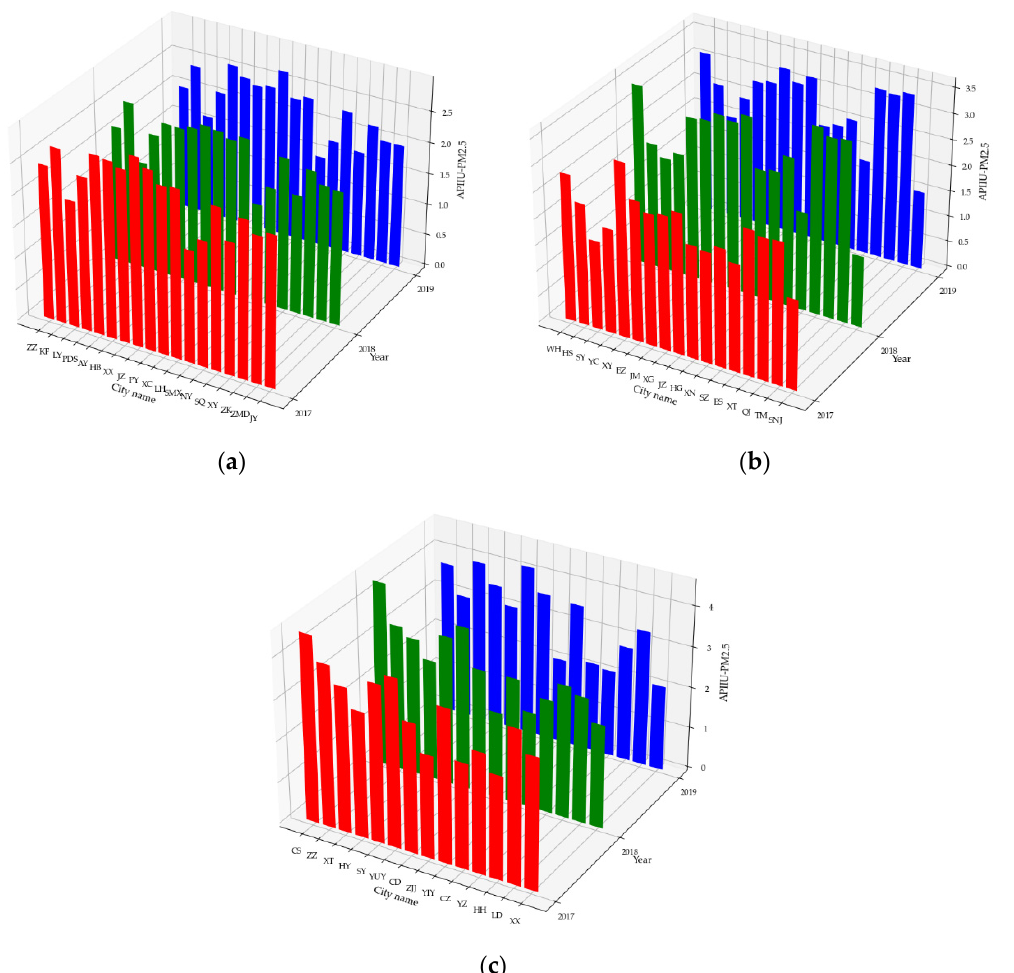
Figure 7. The changing trend of APIIU-AQI from 2017 to 2019: ( a ) Henan Province: Zhengzhou—